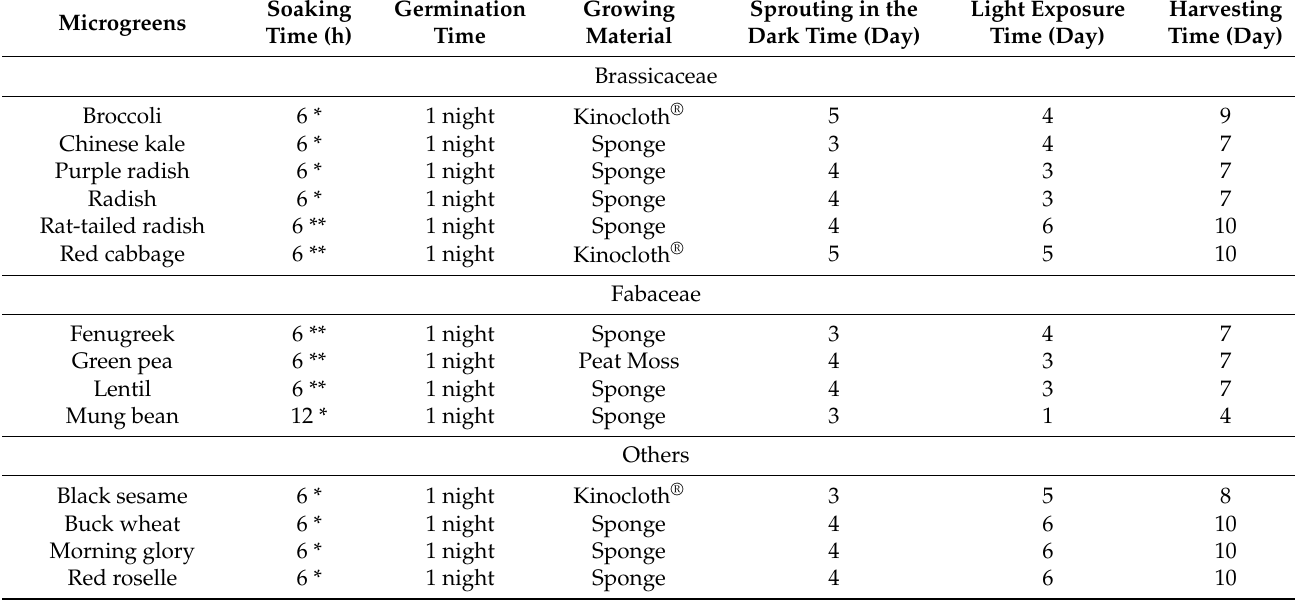
Table 2. Microgreen species, soaking time, germination time, growing material, and durations for sprouting in the dark, light exposure, and